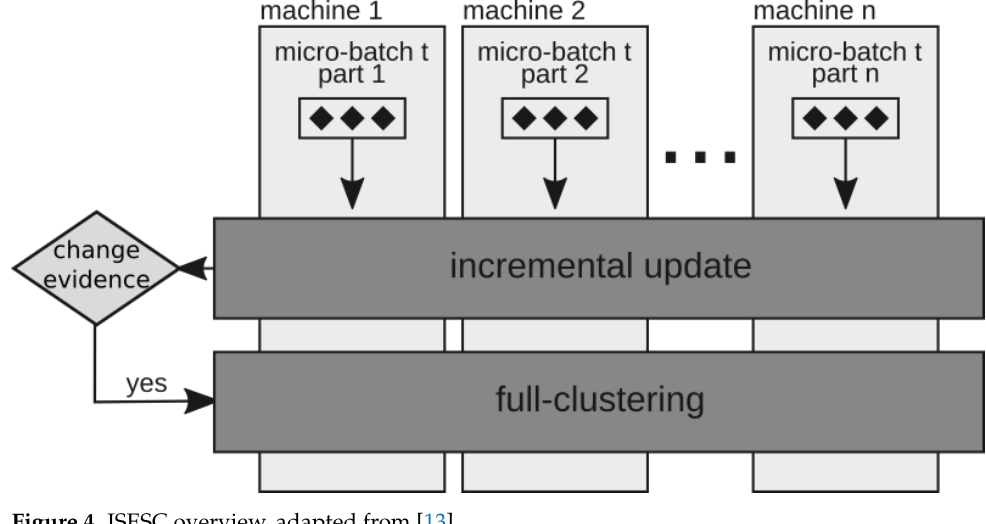
Figure 4. ISESC overview, adapted from